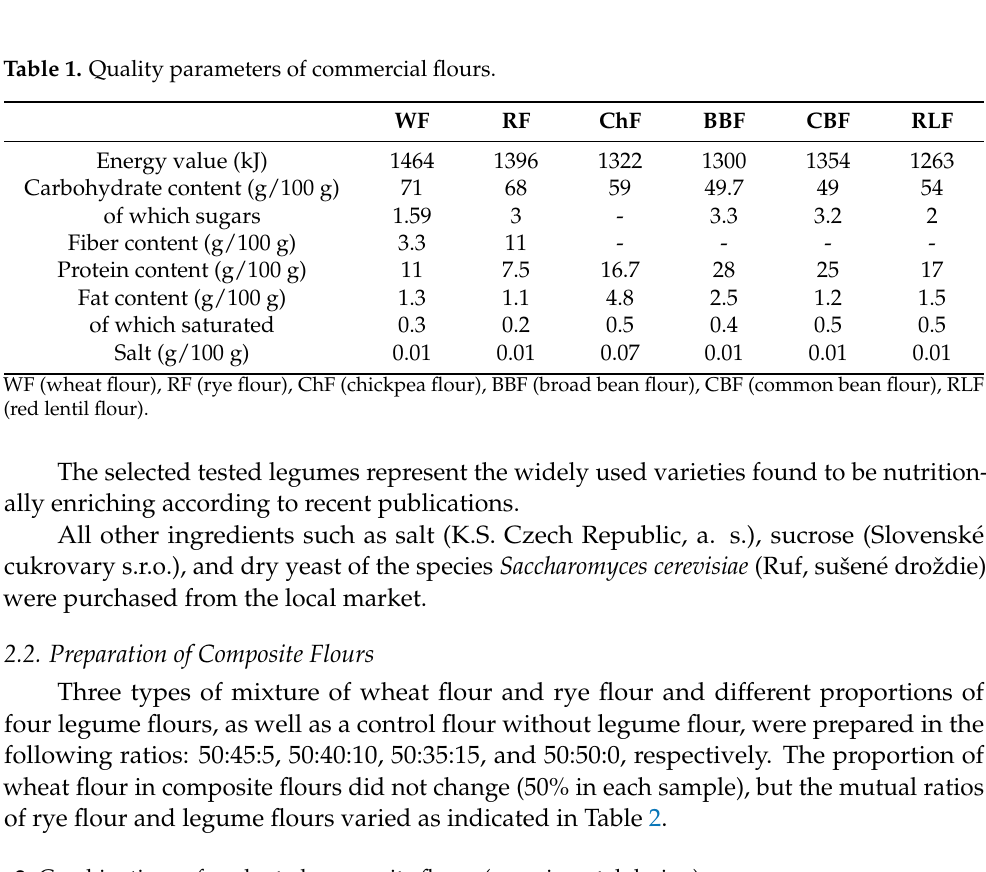
Table 2. Combinations of evaluated composite flours (experimental design). Chickpea Flour Broad Bean